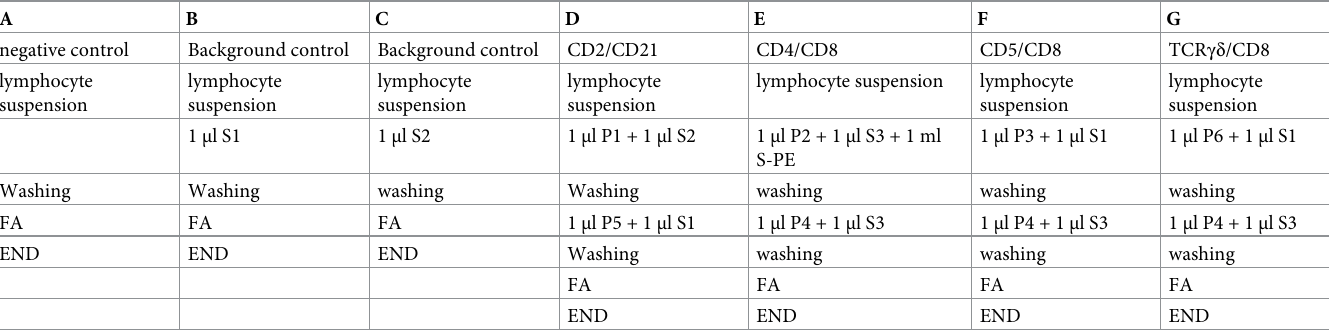
Neuropeptides immunohistochemistry. No age-related differences regarding the num- ber and distribution of the nerve fibers containing the studied neuropeptides were found. Table 3. Procedure used for staining CD antigens in lymphocyte